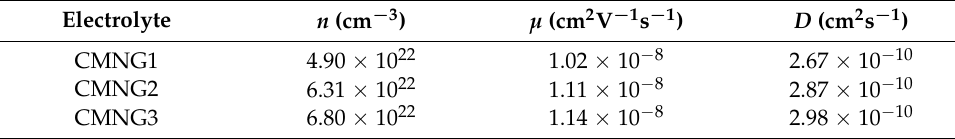
Table 3. Transport parameters values of the